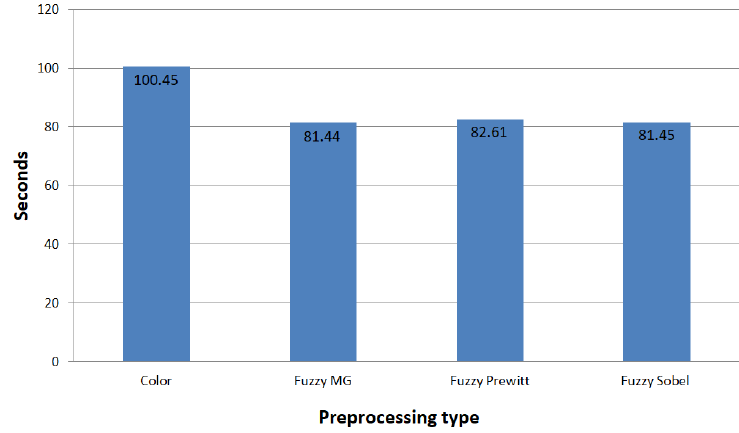
Figure 13. Average training time per model in seconds for CNN-II.